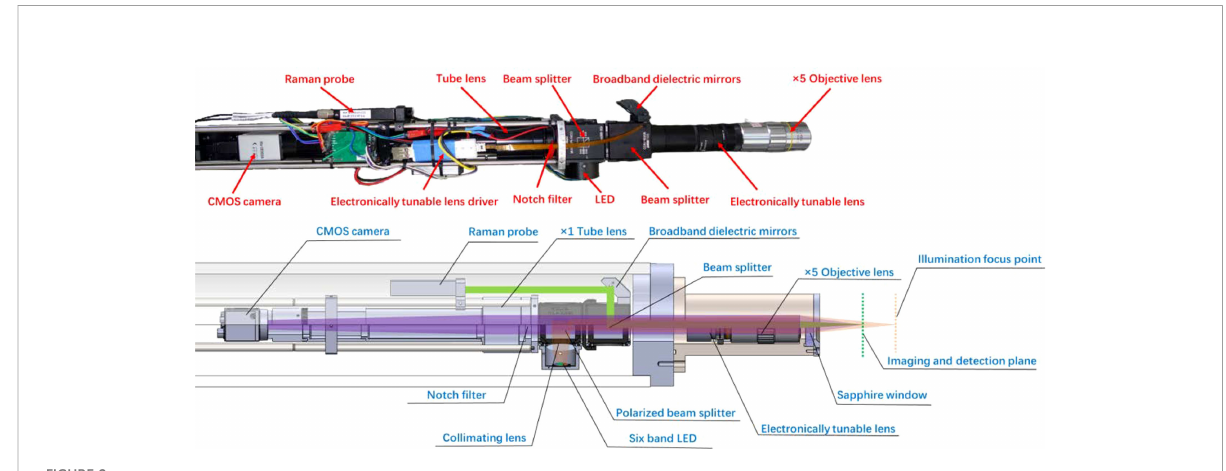
FIGURE 2 The optical layout of the microimaging and Raman detection in